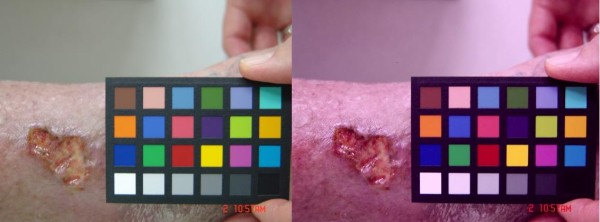
Chronic Wound and Reference Chart. Chronic Wound and Reference Chart after (left) and before (right) calibration.